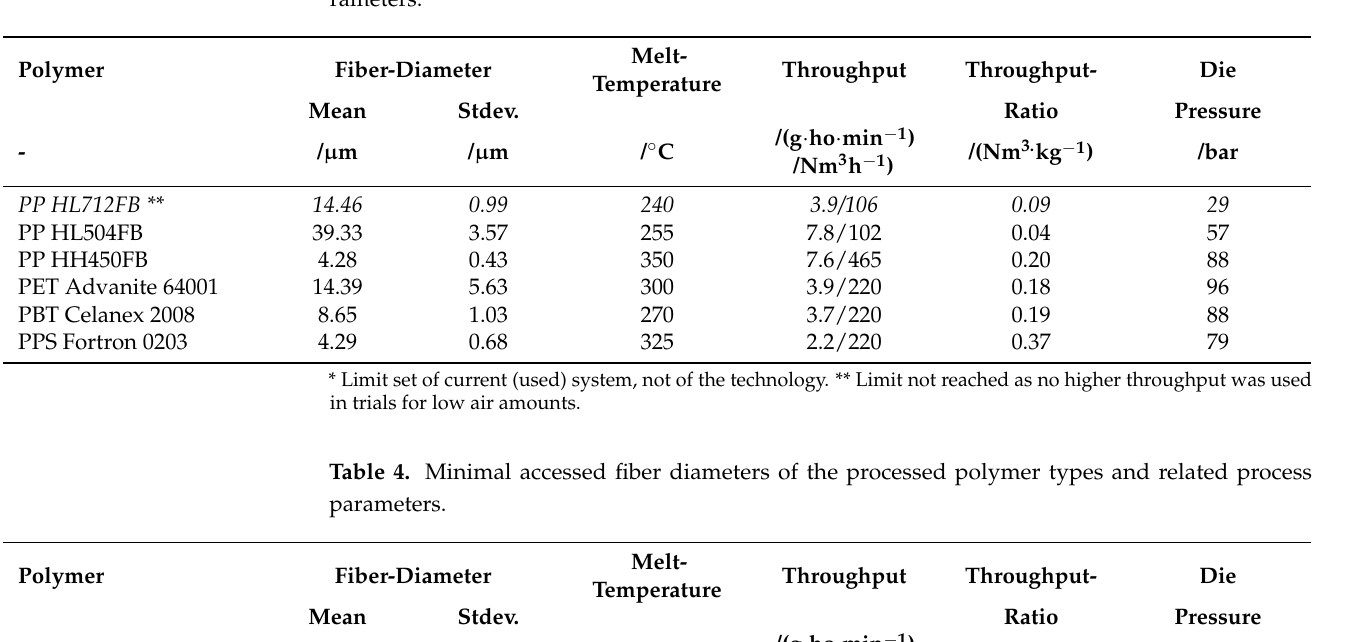
Table 3. Maximal accessible * fiber diameters of the processed polymer types and related process pa- rameters.